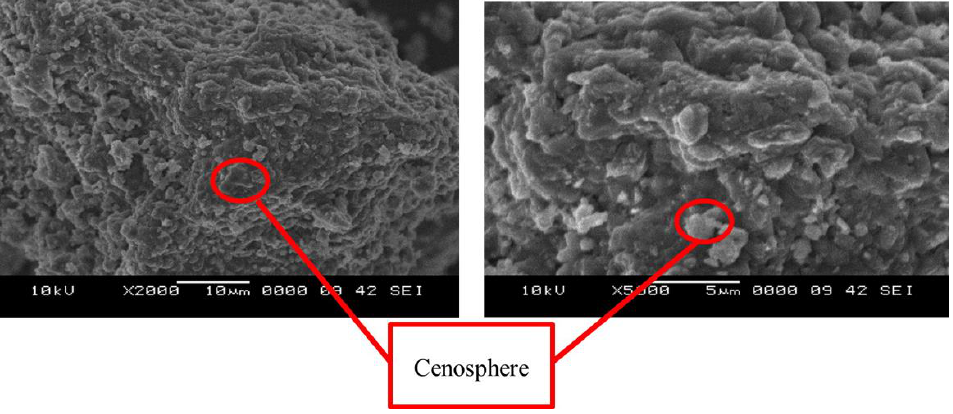
Figure 7. SEM micrographs of the high calcium pozzolanic-based geopolymer at 2000× and 5000× magnification.